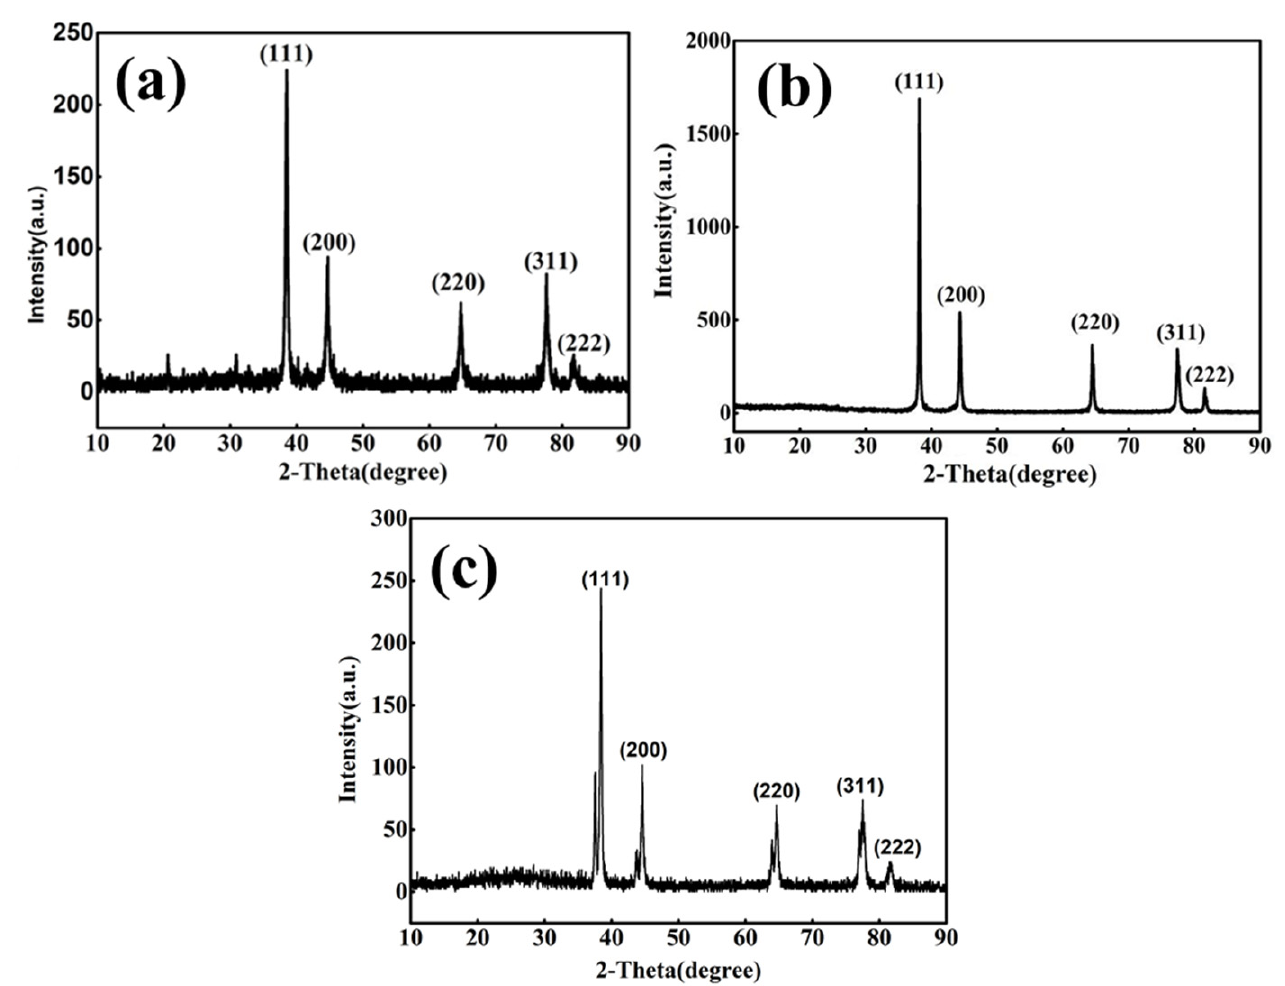
Figure 2. XRD patterns of ( a ) Ag NPs, ( b ) Ag NWs, and ( c ) Ag MFs.